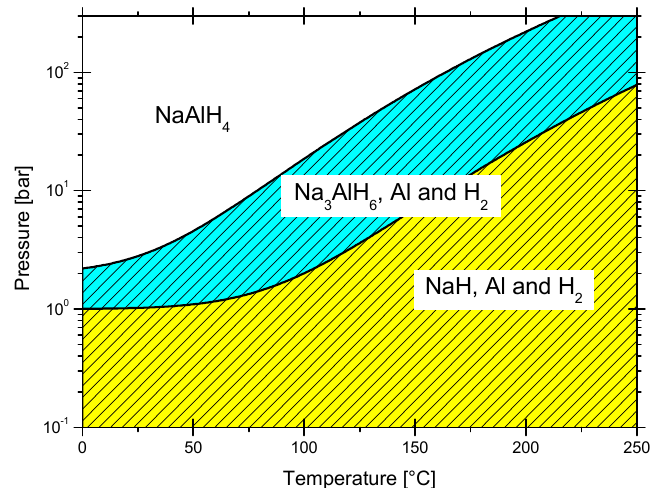
Figure 8. Phase diagram of Ti-doped (Ti(OBu) 4 ) NaAlH 4 , Na 3 AlH 6 , and NaH + Al . Na 3 AlH 6 /NaAlH 4 : (cid:3127)(cid:3117) (cid:4673) = − (cid:2871)(cid:2875)(cid:3038)(cid:3011)·(cid:3040)(cid:3042)(cid:3039) ln (cid:4672) (cid:3043) (cid:3280)(cid:3292) (cid:3043) (cid:3019)(cid:3021)